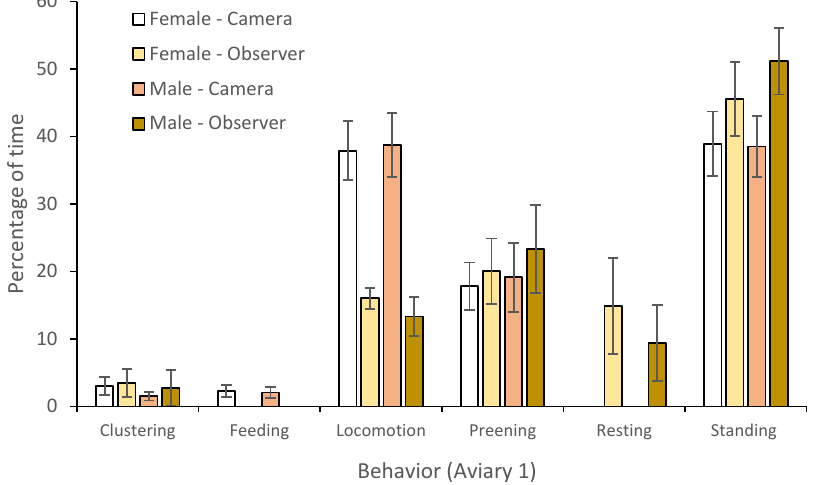
Figure 2. State behavior of pheasant pair housed in aviary 1 (+/ − standard deviation), as compared between observer and camera conditions.